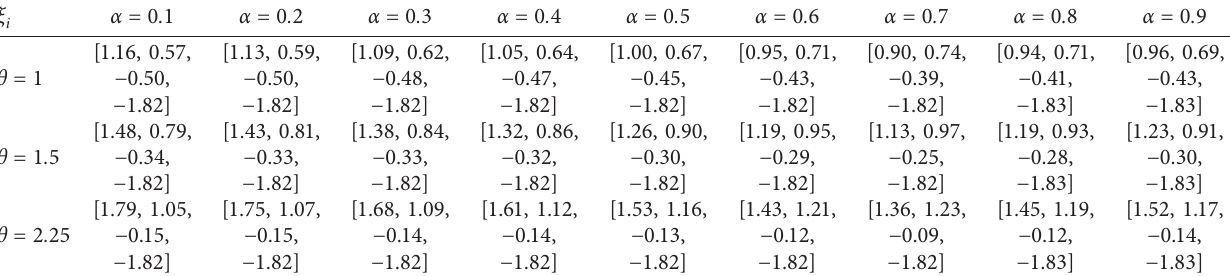
Table 8: The overall dominance values of risk levels with different values of α and θ in case of q � 4.